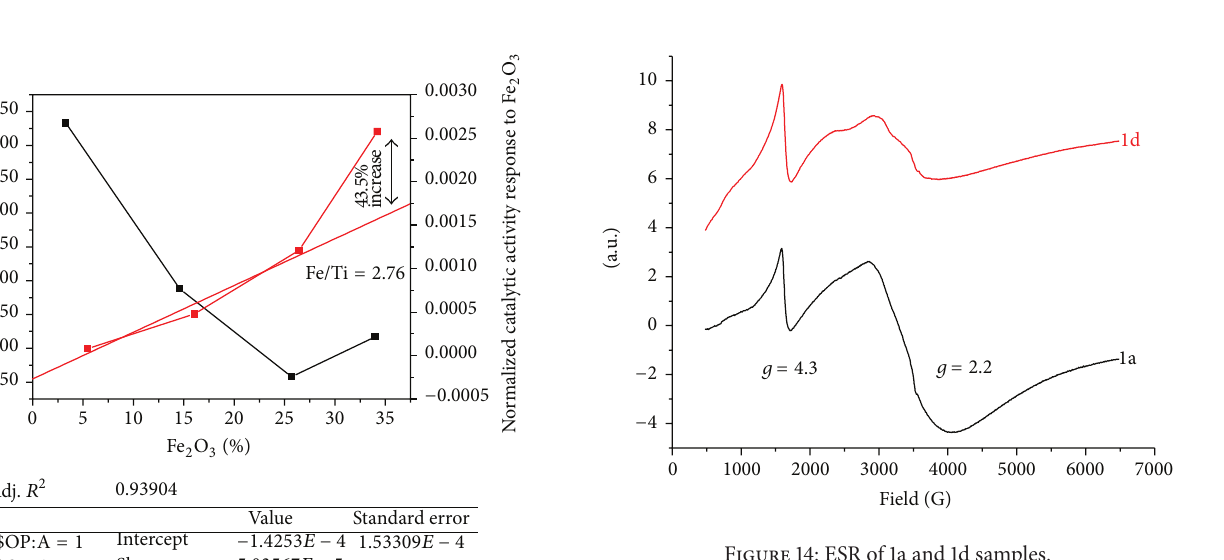
Figure 14: ESR of 1a and 1d